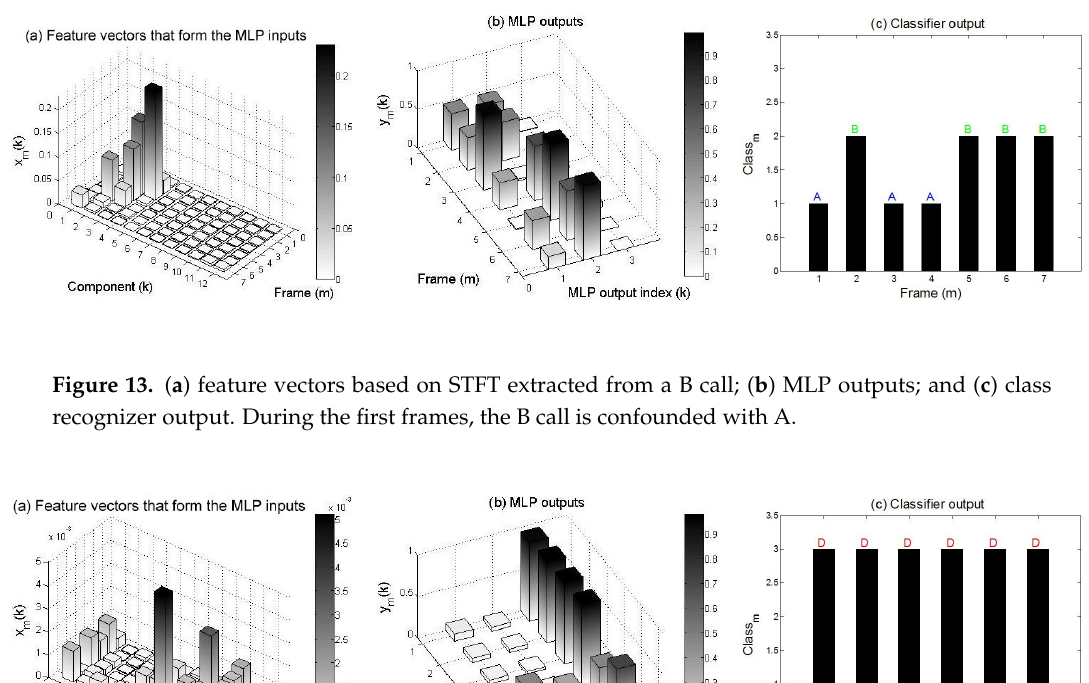
Figure 12. ( a ) feature vectors based on STFT extracted from an A call; ( b ) MLP neural network outputs; and ( c ) class recognizer output. During the first three frames, the A call is confounded with B.